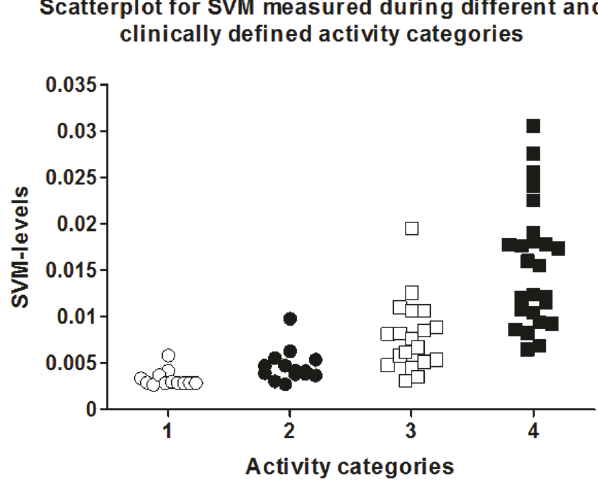
Figure 4: Scatterplot showing measured SVM categorized accord- ing to clinical activity